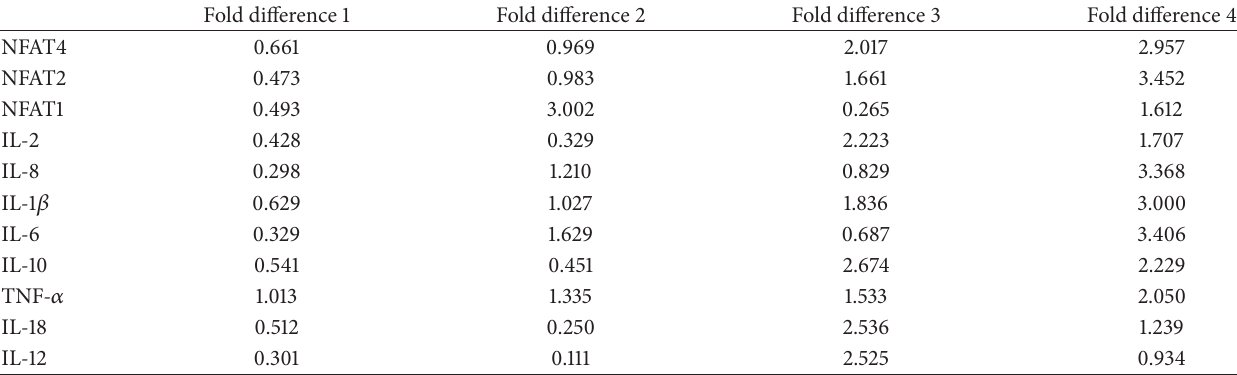
Table 3: Fold change expression and quantitative PCR results of NFAT and cytokines